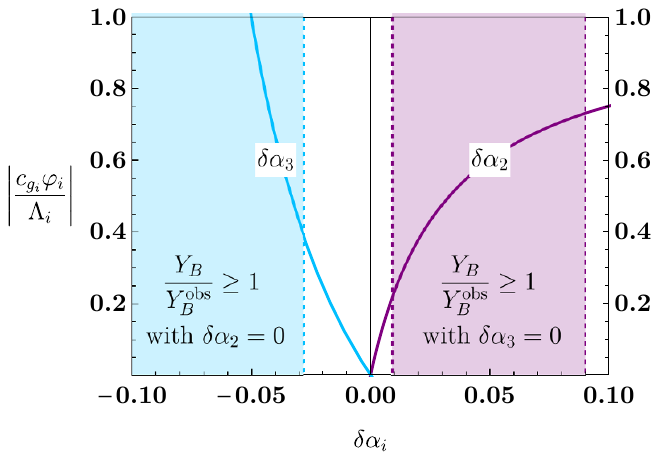
Figure 8 . The absolute value of the dimension-5 operators in eq. (2.1) for a given change in (cid:11) 2 ; 3 . In this scenario we assume the scalar (cid:12)eld ’ 2 ; 3 acquires a vev h ’ 2 ; 3 i before the EW phase transition, shifting the gauge couplings by (cid:14)(cid:11) 2 ; 3 . In the purple shaded (on the right half of the plot), the BAU is produced without any change in (cid:11) 3 , while in the blue shaded region (on the left half of the plot) BAU is produced without changing (cid:11) 2 . Note that the produced asymmetry could be larger than observed in these